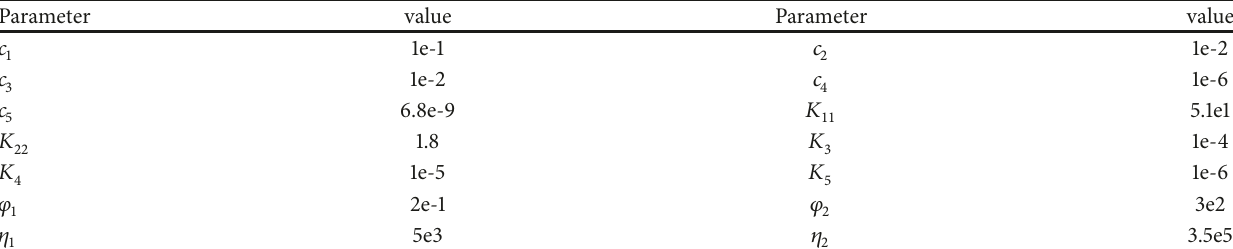
Table 2: Backstepping sliding mode adaptive controller